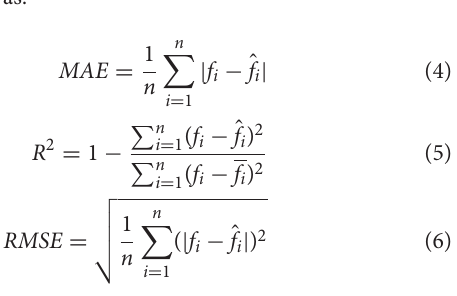
Frontiers in Environmental Science |